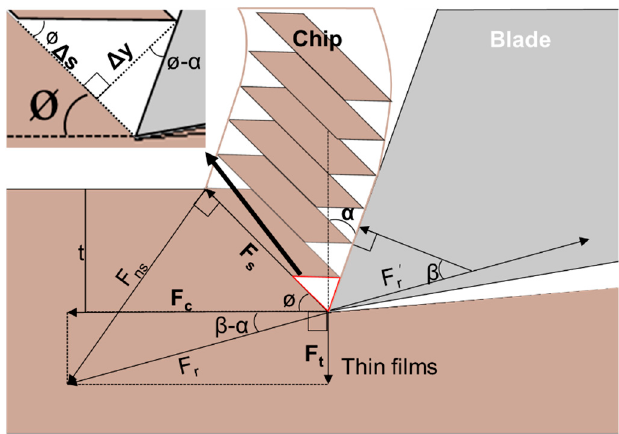
Figure 1. Merchant’s orthogonal cutting model.